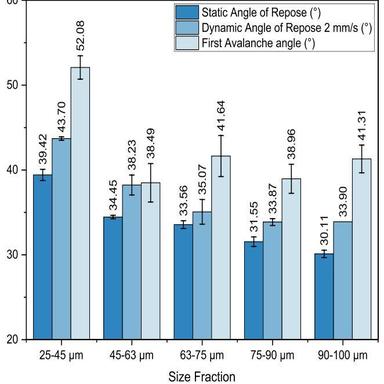
Comparison of the static angle of repose, dynamic angle of repose and GranuDrum's first avalanche angle.